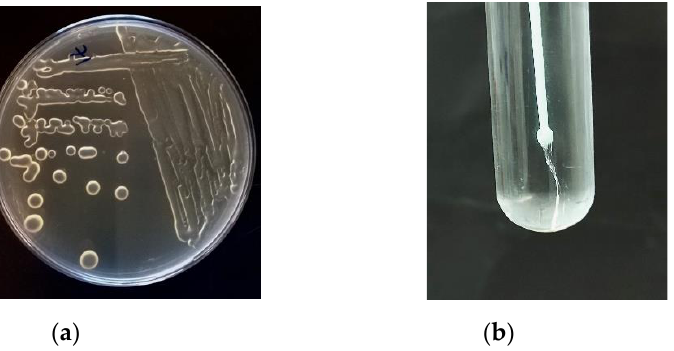
Figure 1. Characteristics of EPS produced by LAB: ( a ) Mucoid colonies—slimy phenotype; ( b ) Ropy phenotype.